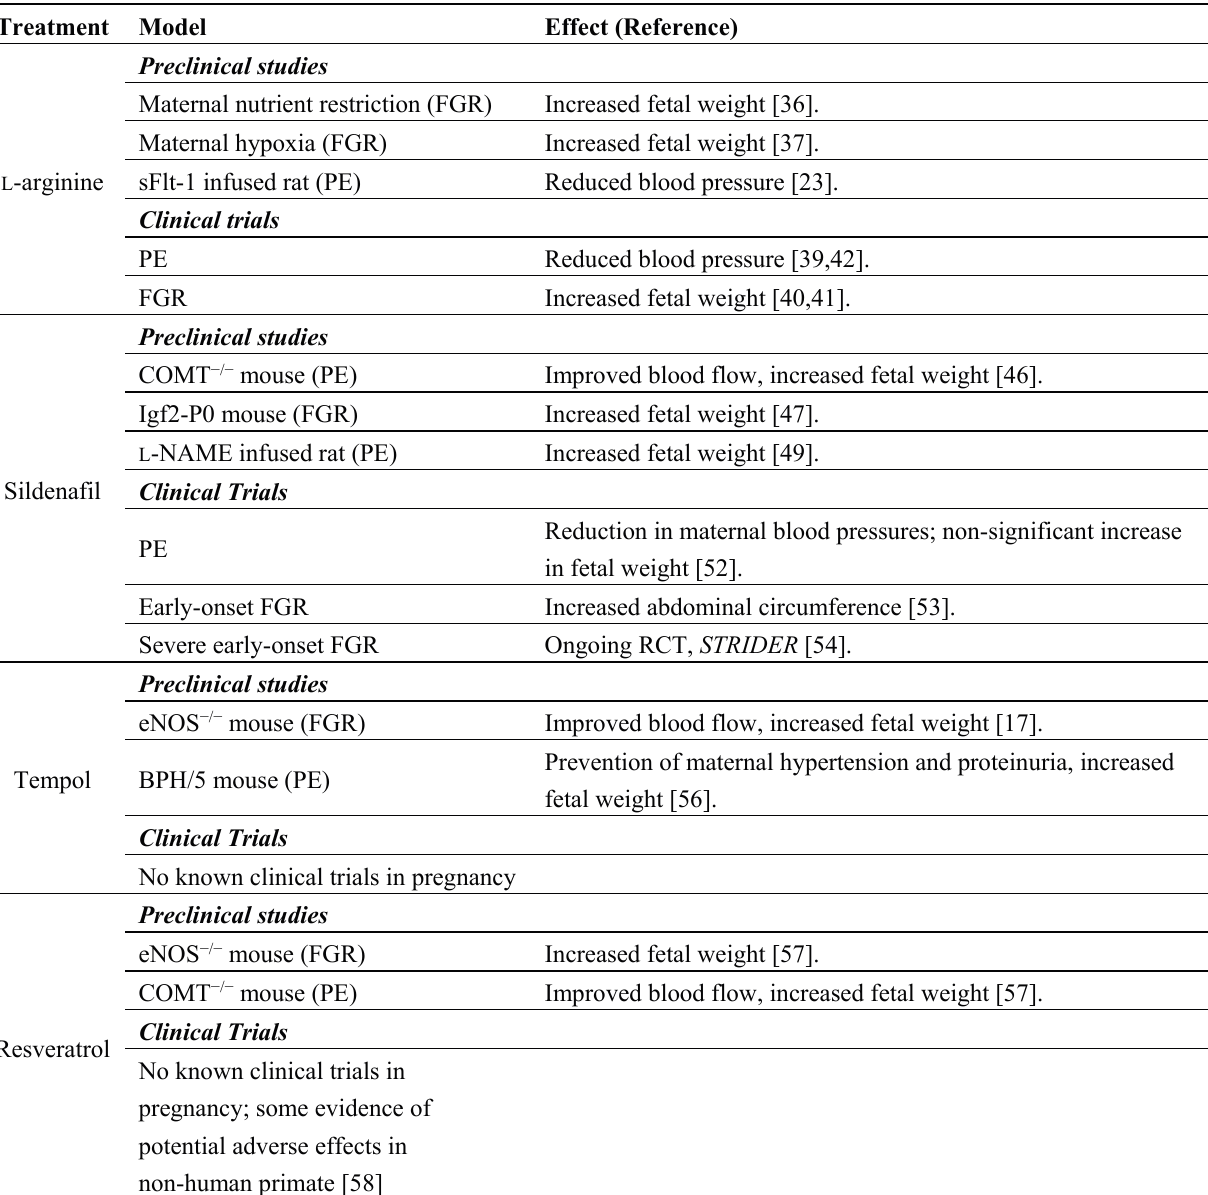
Table 1. Summary of treatment strategies used in preclinical models of fetal growth restriction (FGR) and preeclampsia (PE), and their translation to clinical trials (where